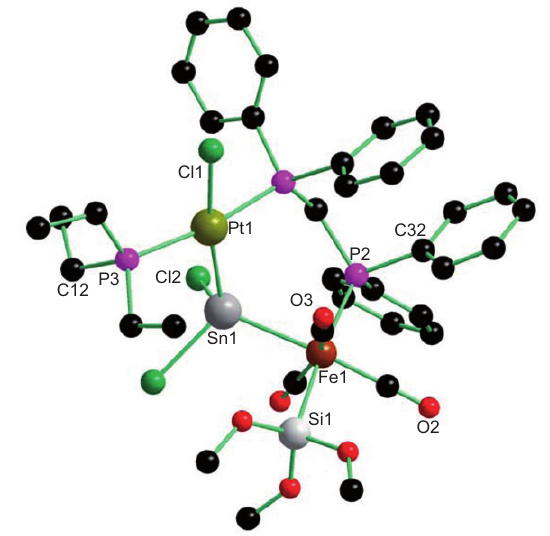
)(Cl)Pt( μ -dppm)Fe(CO) 3